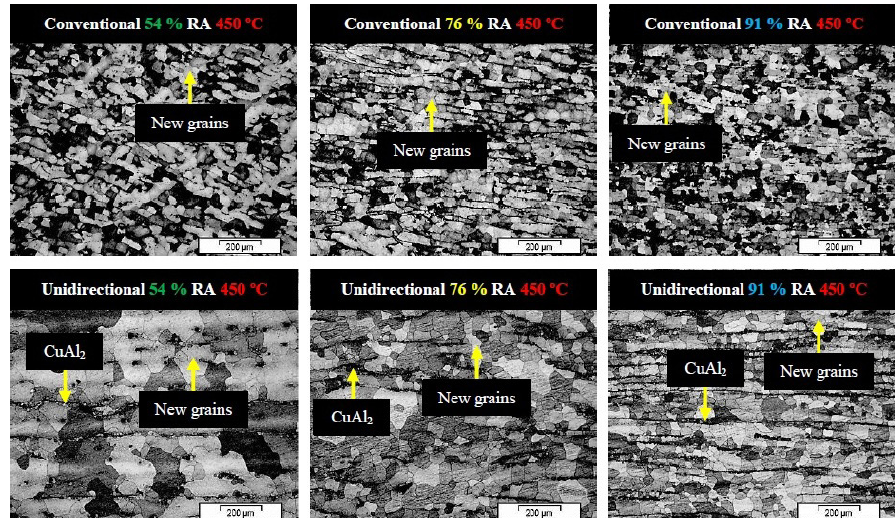
Figure 12. Micrographs of the Al4.5wt%Cu alloy conventionally and unidirectionally solidified after 54, 76 and 91% of RA and heat treatment of 450 ºC.